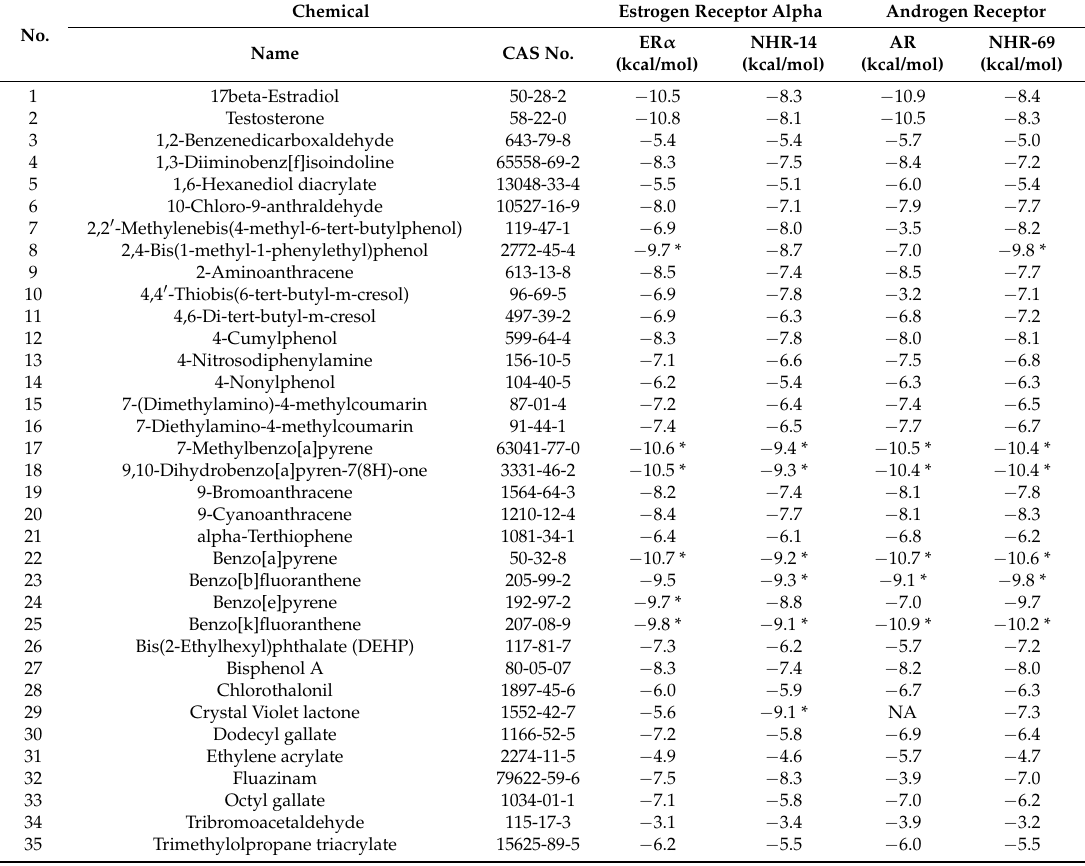
Table 1. Calculated binding affinity of the ligands on human estrogen receptor alpha (ER α ) and androgen receptor (AR), and C. elegans NHR-14 and NHR-69.